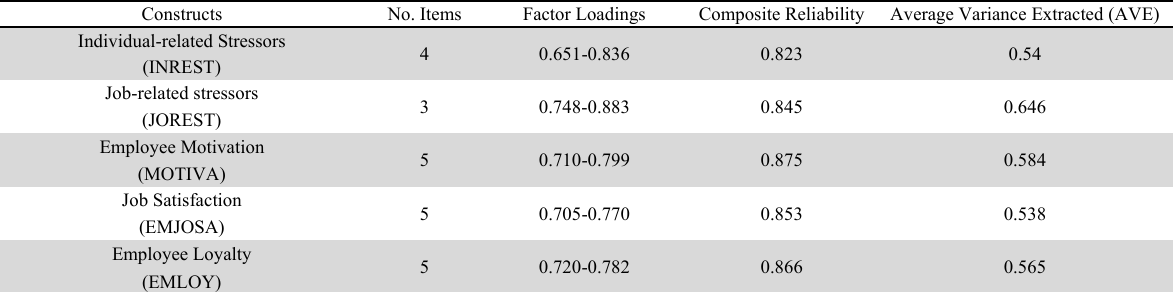
Reliability and Convergent Validity